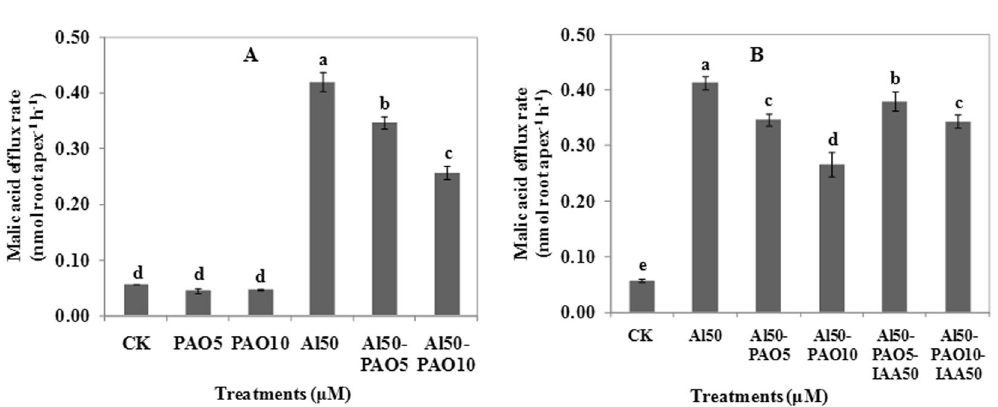
Figure 3. Effects of protein kinase inhibitor PAO and IAA on malic acid efflux from 4-day-old wheat seedlings. Seedlings were exposed to 0.5 mM CaCl 2 solution (pH 4.5) containing other chemicals: ( A ) 0 μ M AlCl 3 (CK), 5 (10) μ M PAO, 50 μ M AlCl 3 , 50 μ M AlCl 3 and 5 (or 10) μ M PAO for 24 h; ( B ) 0 μ M AlCl 3 (CK), 50 μ M AlCl 3 , 50 μ M AlCl 3 and 5 (or 10) μ M PAO, 50 μ M AlCl 3 and 50 μ M IAA and 5 (or 10) μ M PAO for 24 h. Data are means ± SD (n = 3). Small letter differences in the same figure mean significant difference at P <